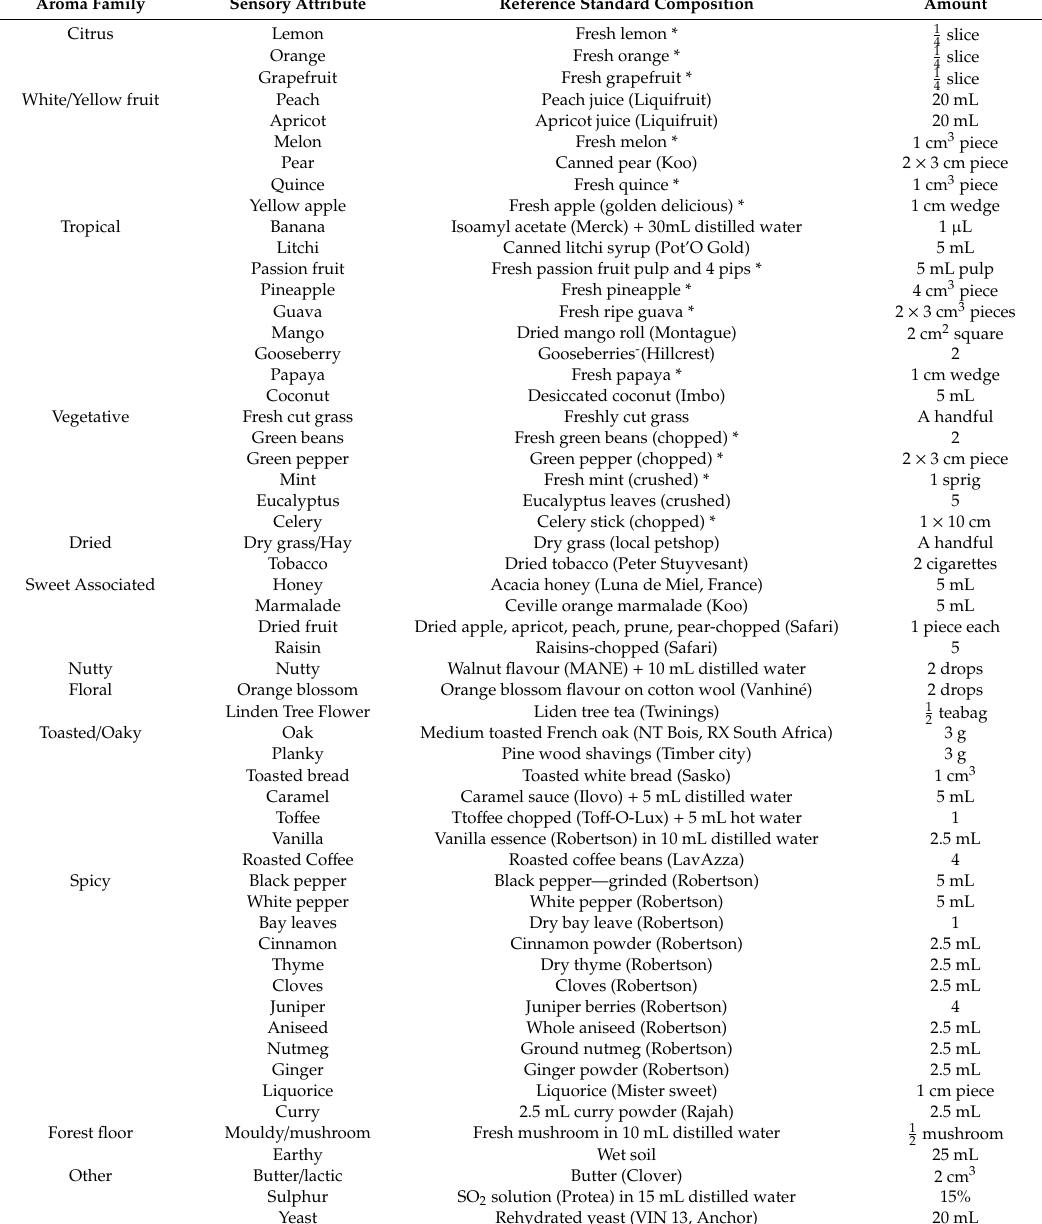
Table A1. Aroma attributes and the composition of the reference standards presented during panel training. Aroma